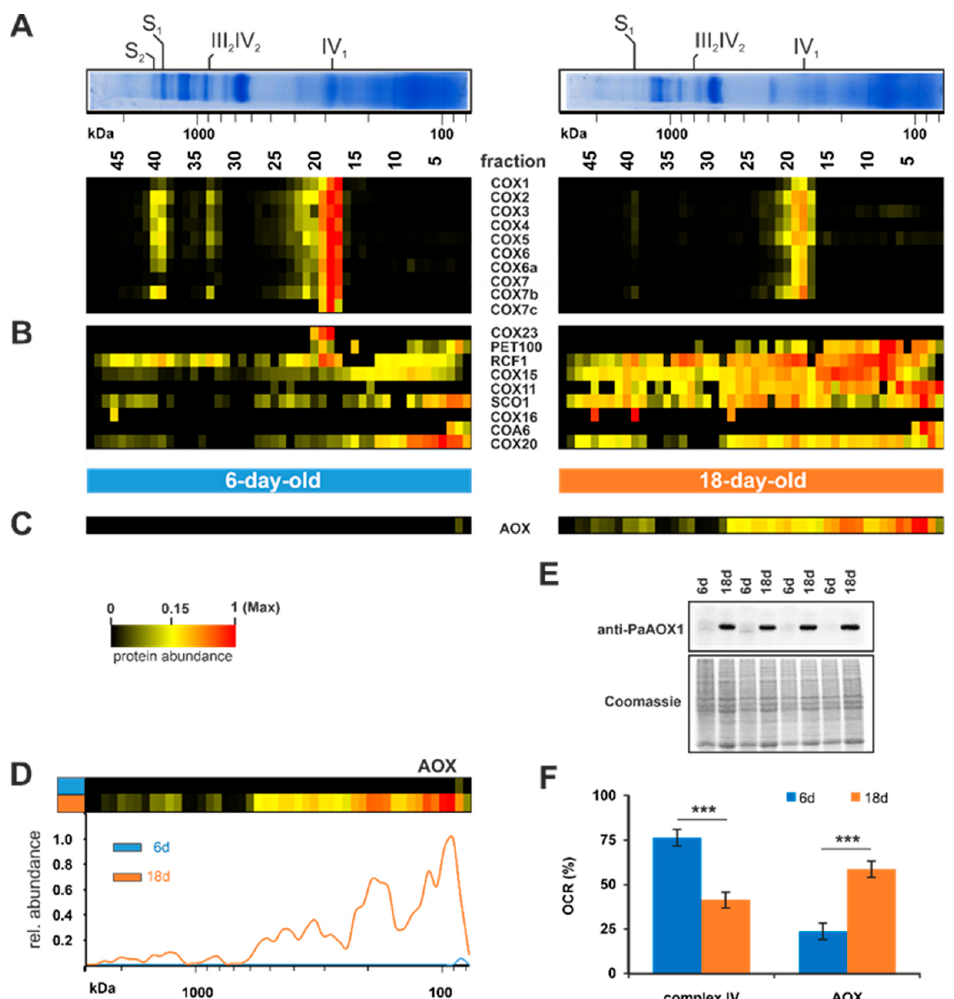
Figure 4. Age ‐ dependent switch to AOX ‐ dependent respiration. ( A ) Quantified subunits of complexes IV, ( B ) additional complex IV proteins and assembly factors, and ( C ) the alternative oxidase (AOX) are represented in a heat map. The color scale ranges from black (not identified), to yellow (15% of the maximum), to red (maximum abundance). ( D ) Complexome distribution profiles of alternative oxidase of 6 ‐ day ‐ old and 18 ‐ day ‐ old wild ‐ type cultures. ( E ) Western blot analysis of mitochondrial protein extract of 6 ‐ day ‐ and 18 ‐ day ‐ old P. anserina wild ‐ type cultures (each with 4 biological replicates). A specific PaAOX1 antibody was used to detect the ~34 kDa alternative oxidase (PaAOX). Coomassie staining served as loading control. ( F ) Relative complex IV ‐ and AOX ‐ dependent oxygen consumption rate (OCR) of 6 ‐ day ‐ and 18 ‐ day ‐ old wild ‐ type mycelium after treatment with SHAM (AOX ‐ inhibitor) or KCN (complex IV ‐ inhibitor).